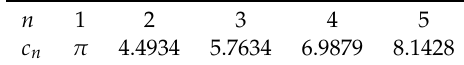
Table 2. Values of uses parameters for the b n and a n pole